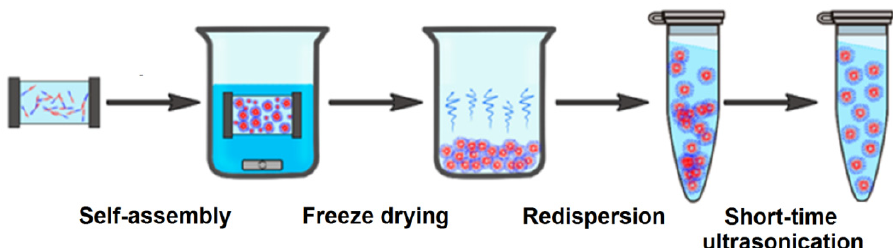
Figure 8. Scheme for the preparation of self-assembled soft nanoparticles.